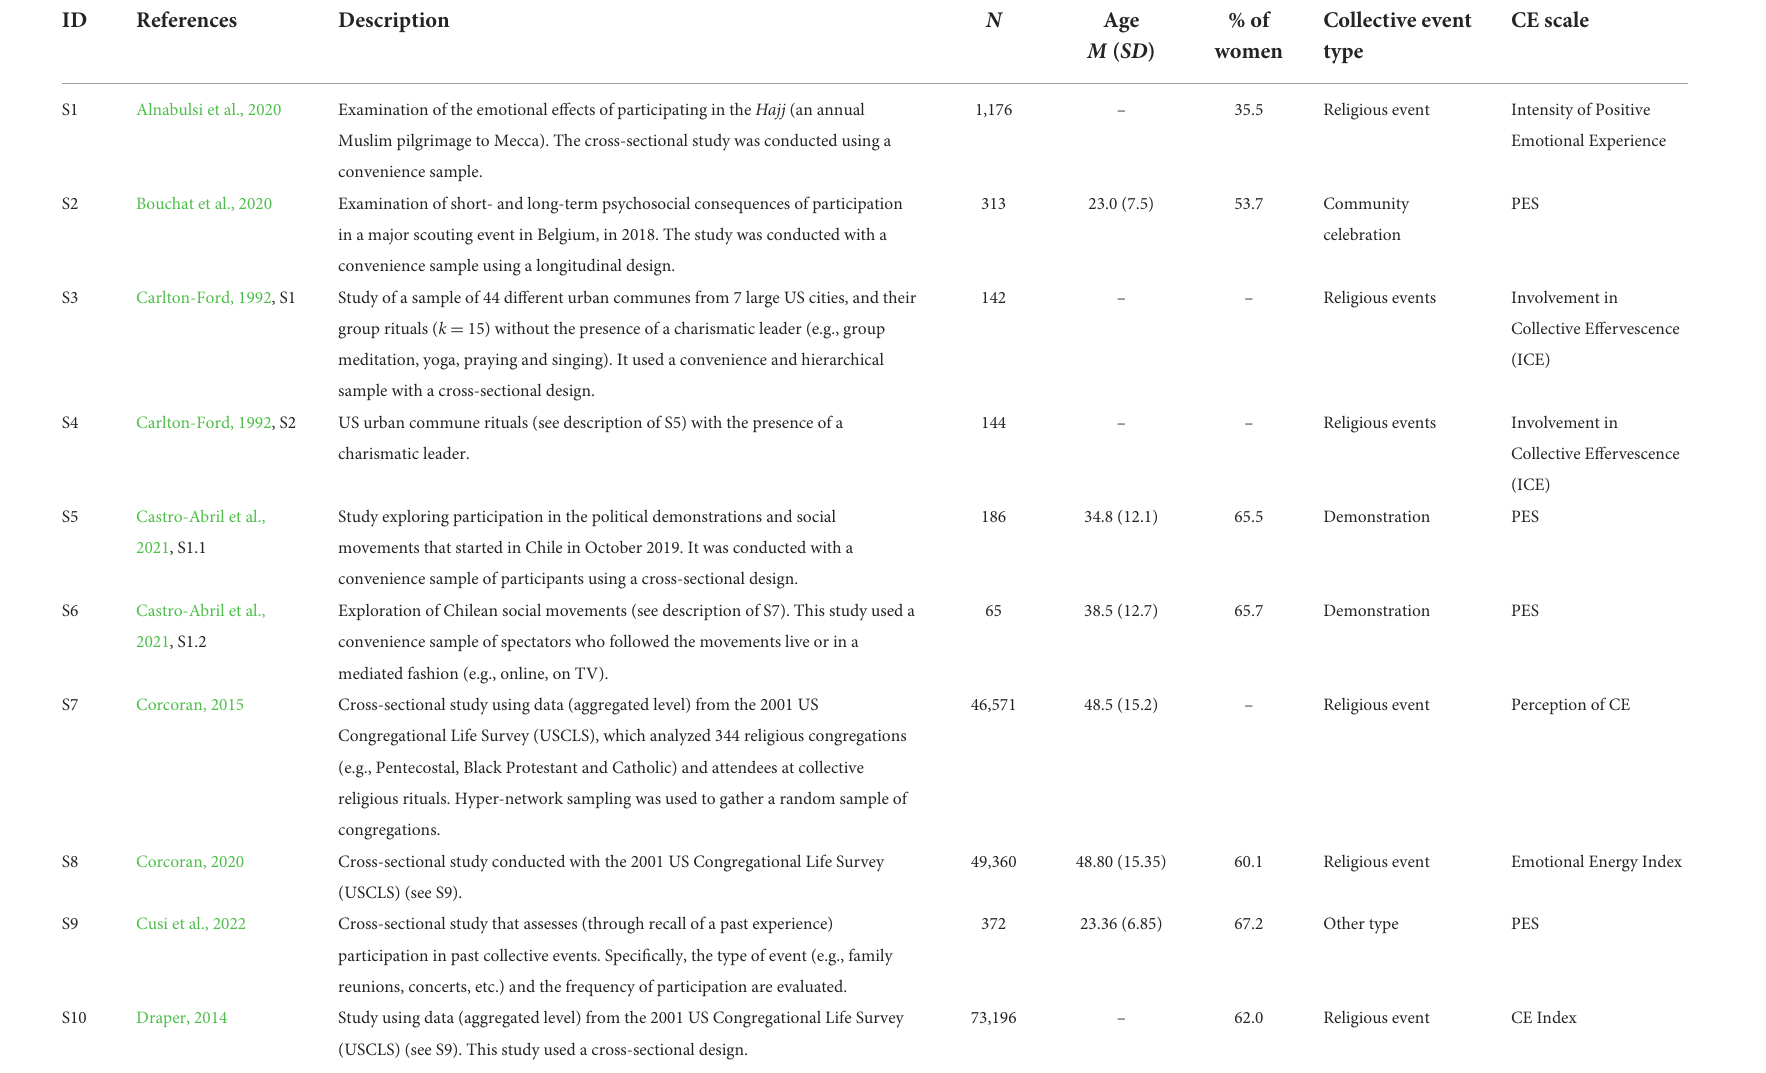
TABLE 2 Descriptions and characteristics of studies included in the